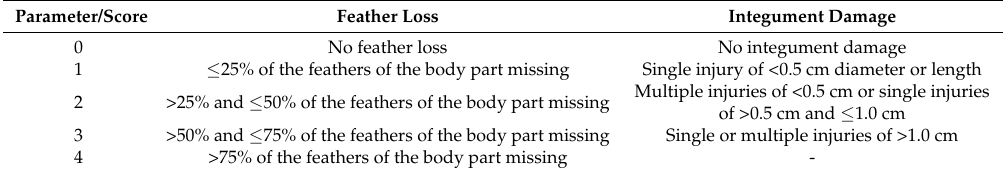
Table 1. Description of the scoring scheme used for the assessment of plumage and integument condition in conventional layer hybrids and dual-purpose